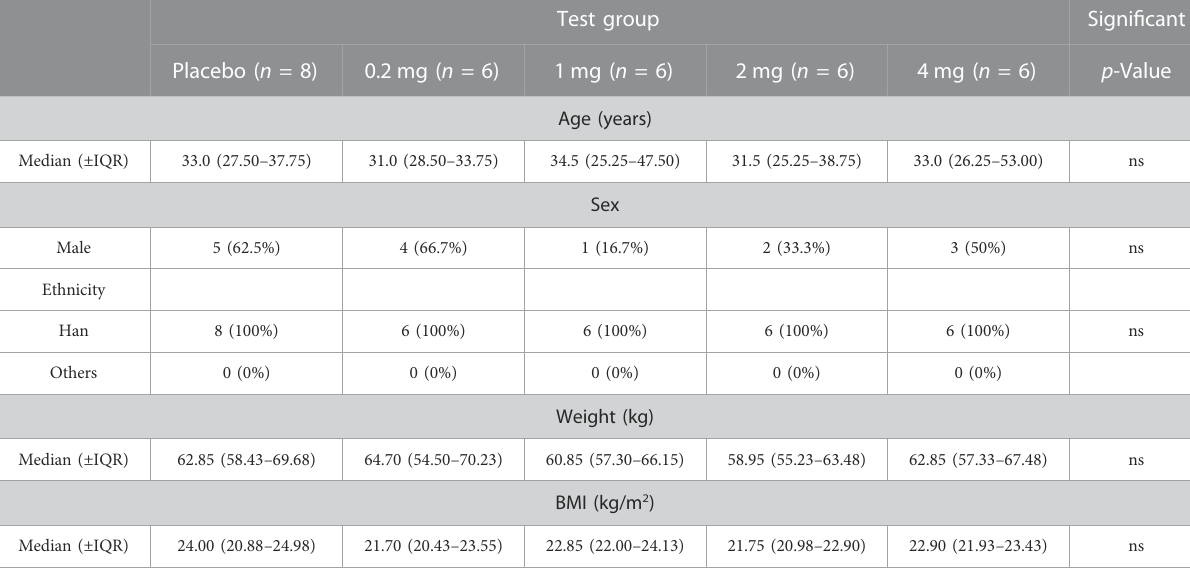
The signi fi cant difference analysis was evaluated using Chi-squared test and one-way ANOVA, with Tukey ’ s multiple comparison test. (ns: non signi fi cant).